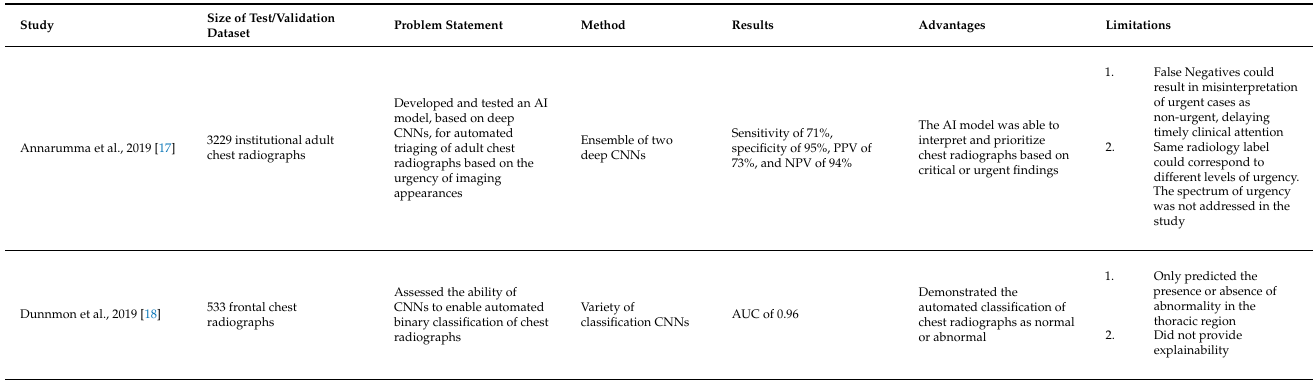
Table 1. A literature review of research articles investigating the role of AI in detecting pathologies from chest